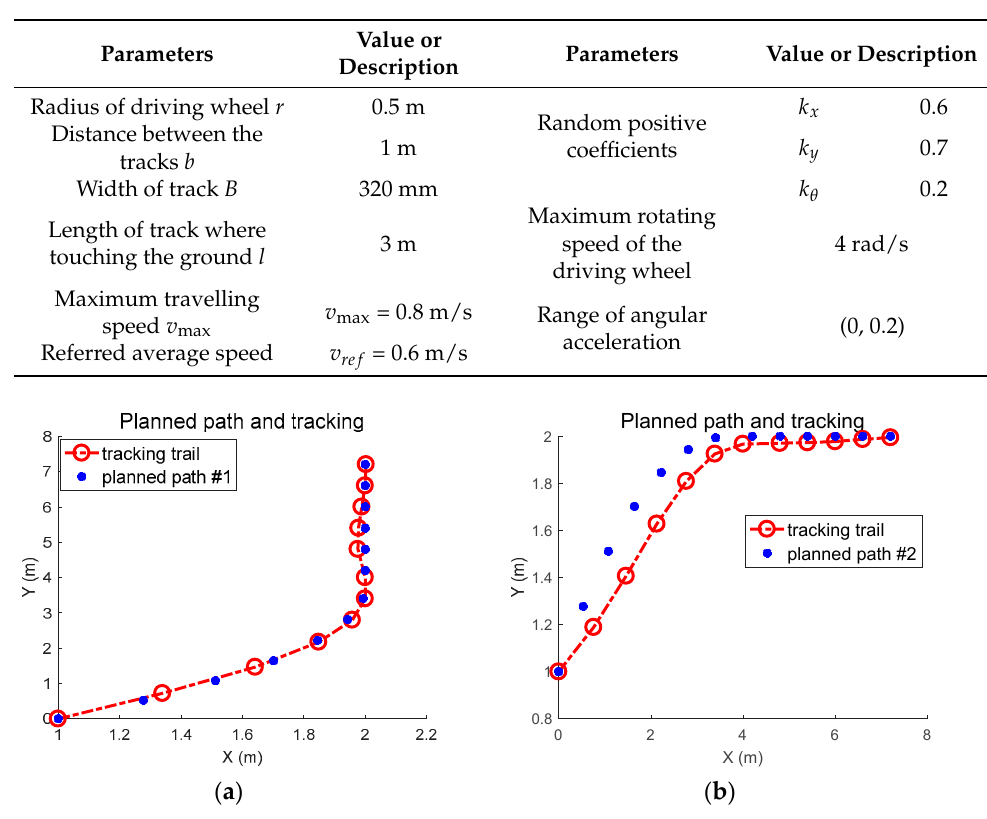
Figure 4. Path tracking results based on the pose deviation model. ( a ) The differences between the planned positions along path #1 and the real positions during tracking; ( b ) The differences between the planned positions along path #2 and the real positions during tracking.